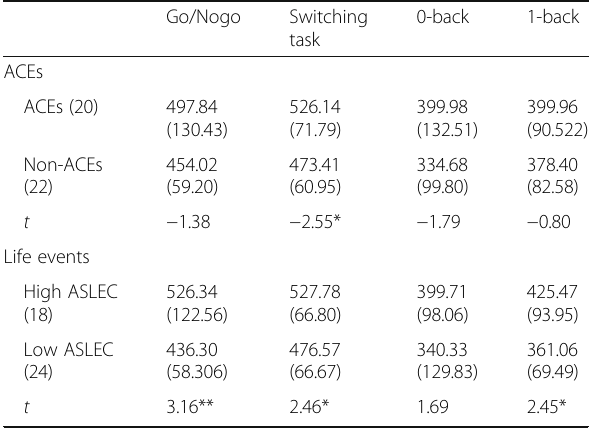
Table 5 Independent sample T test Go/Nogo Switching task